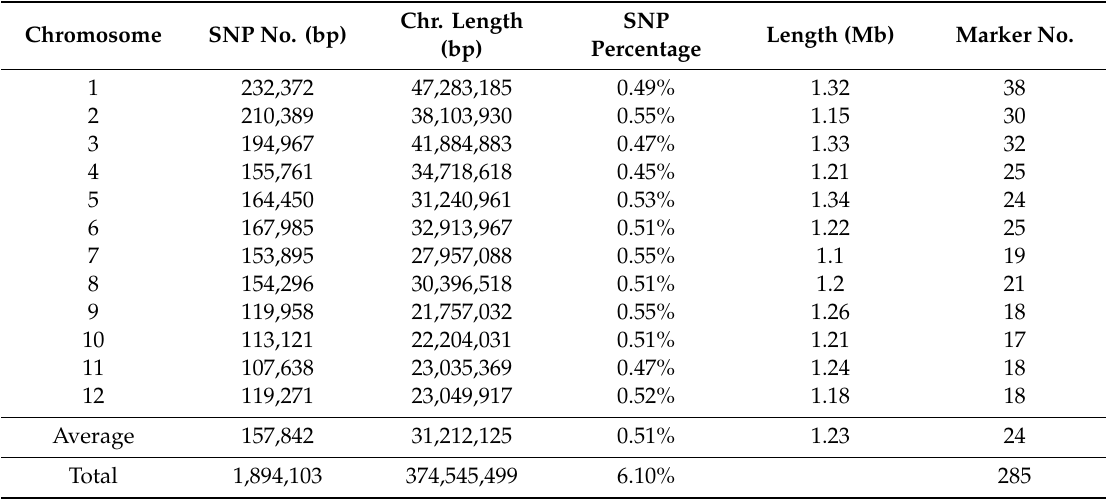
Table 1. Number of single-nucleotide polymorphism (SNPs) detected in wild rice (DP30). Chromosome SNP No. (bp)